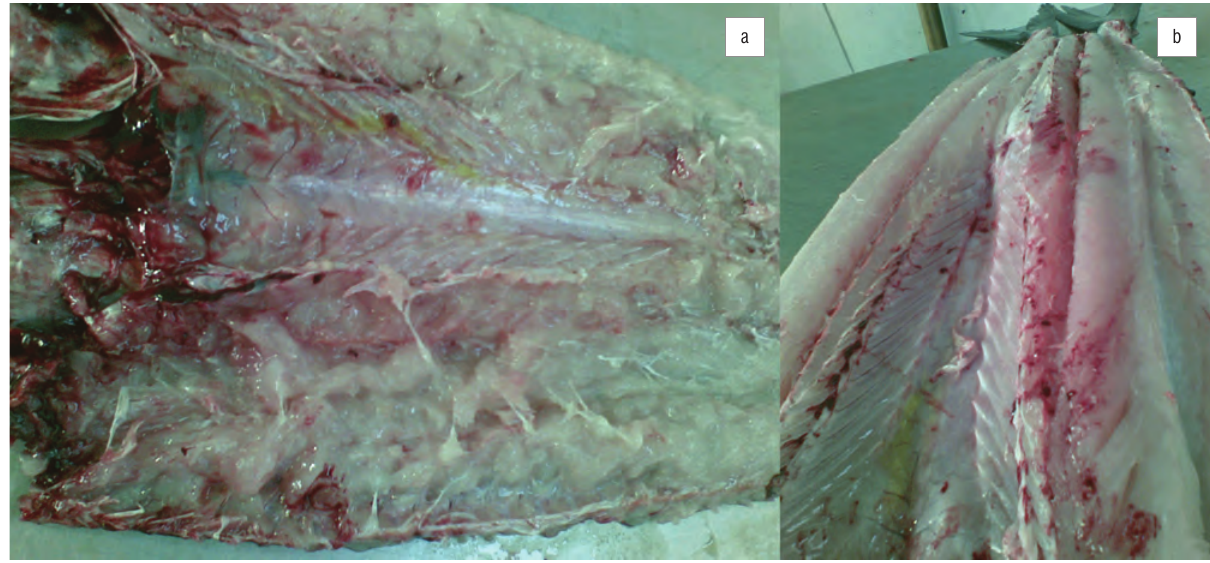
Figure 1: Refrigerated (5 °C) flecked Cape snoek ( Thyrsites atun ) musculature at 48 h post-mortem (a) with and (b) without Table 1: A summary of reports of marine fish species, from different geological areas, infected by Kudoa thyrsites